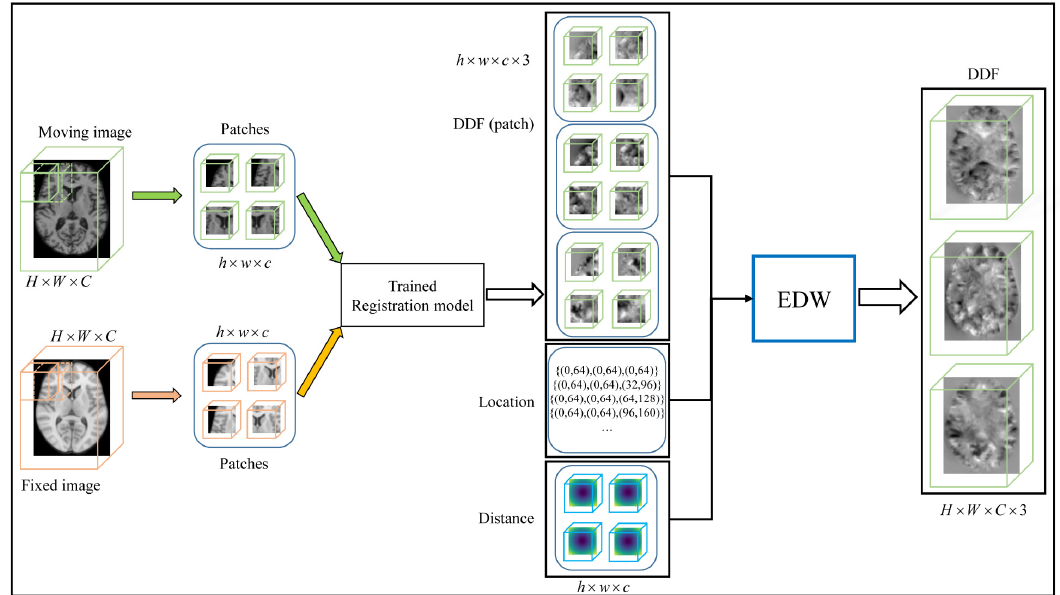
Figure 6. The pipeline of patch fusion in the test phase. The size of both the moving image and the fixed image is H × W × C , and the overlapping patches of size h × w × c are extracted using the sliding window with stride s . The DDF patch of h × w × c × 3 is obtained by the trained registration model. The output DDF patch is located at the same location as the input patch. Finally, the whole DDF is obtained by the EDW method.